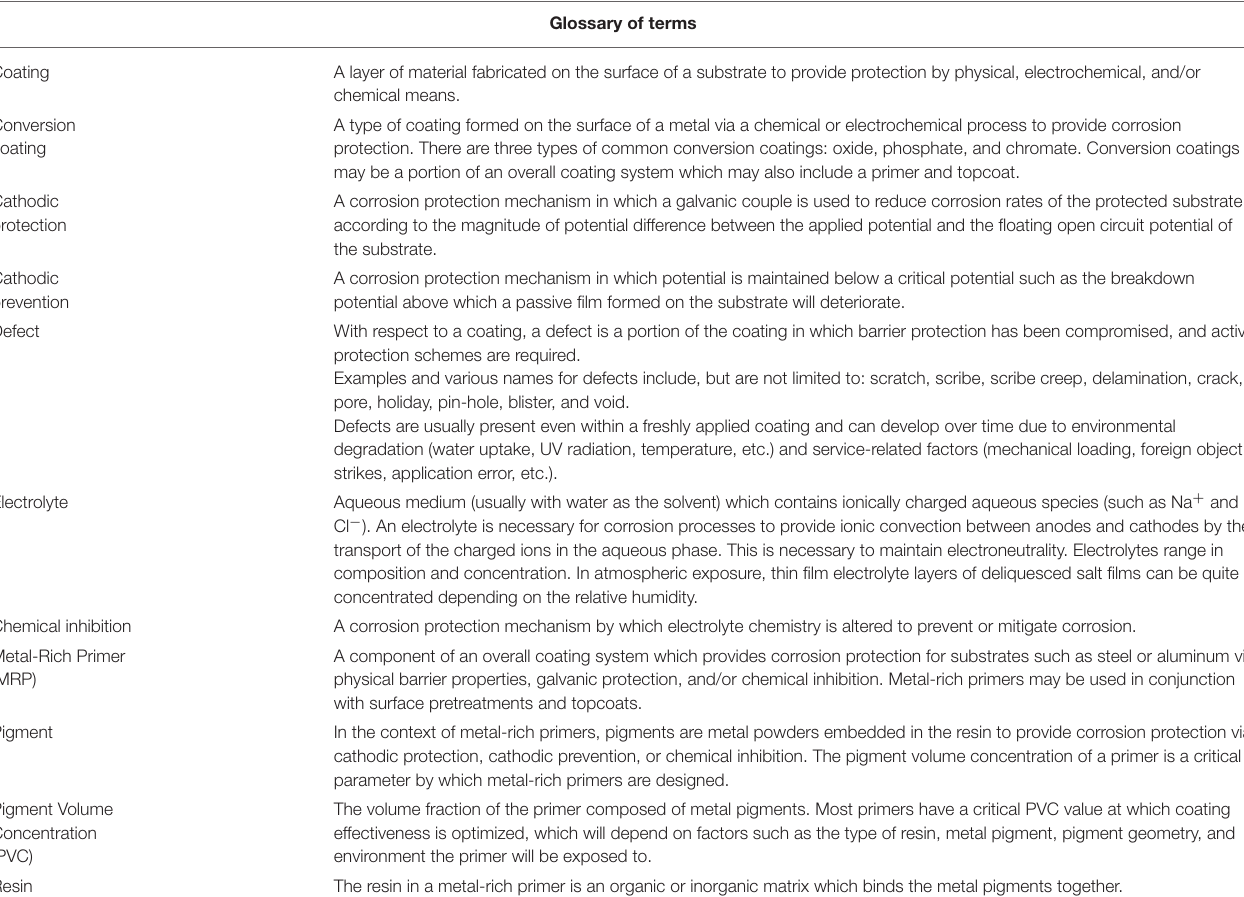
TABLE 1 | Glossary of critical terms for the topic of metal-rich